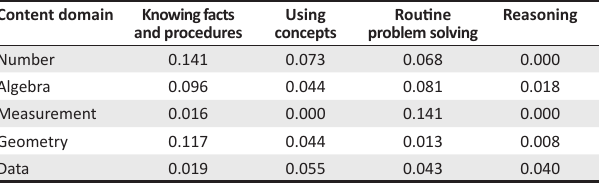
TABLE 5: Results of coding the TIMSS 2003 assessment objectives by content and cognitive domain.